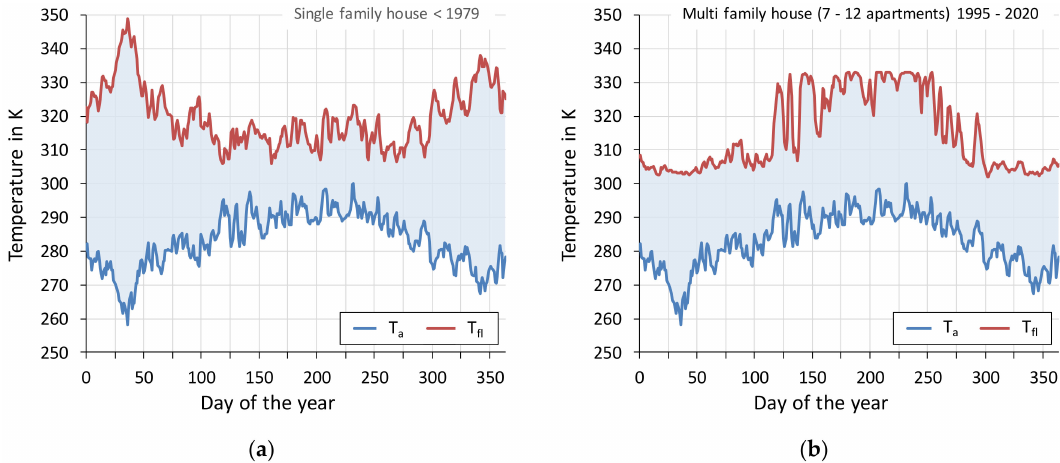
Figure 3. Ambient air temperature (T a ) and floor temperature (T fl ) of an air source heat pump in a single family house of the building age class before 1979 ( a ) and a multi-family house with seven to 12 apartments of the building age class 1995 to 2020 ( b